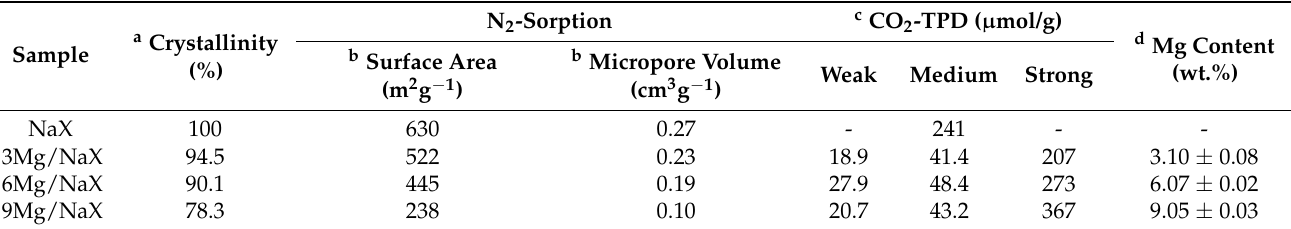
Figure 1. XRD patterns of zeolite NaX and magnesium loaded on NaX. Table 1. Crystallinity, textural properties, basicity and magnesium content of the